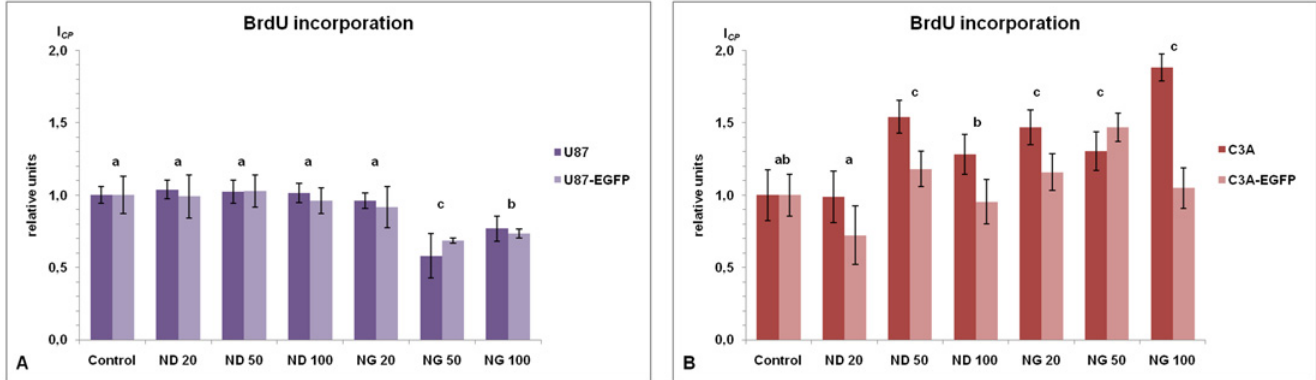
Fig 5. BrdU incorporation test. U87, U87-EGFP, C3A and C3A-EGFP cells proliferation (expressed as I CP ) analysis was performed 24 h after treatment with the culture medium containing nanoparticles at different concentrations: diamond 20 μ g/mL (ND 20), 50 μ g/mL (ND 50) and 100 μ g/mL (ND 100), and graphite 20 μ g/mL (NG 20), 50 μ g/mL (NG 50) and 100 μ g/mL (NG 100); nontreated cells were used as a control (Control). ( A ) U87 and U87-EGFP cells and ( B ) C3A and C3A-EGFP cells after 24 h of exposure to the medium with different concentrations of diamond and graphite nanoparticles. Data analysis was carried out by two-way ANOVA and the differences between the groups were tested by Duncan ’ s test. Data were averaged from three replicates (n = 3); P < 0.05. We observed significant interactions (nanoparticles with transduction) in glioblastoma cells ( P = 0.0001).